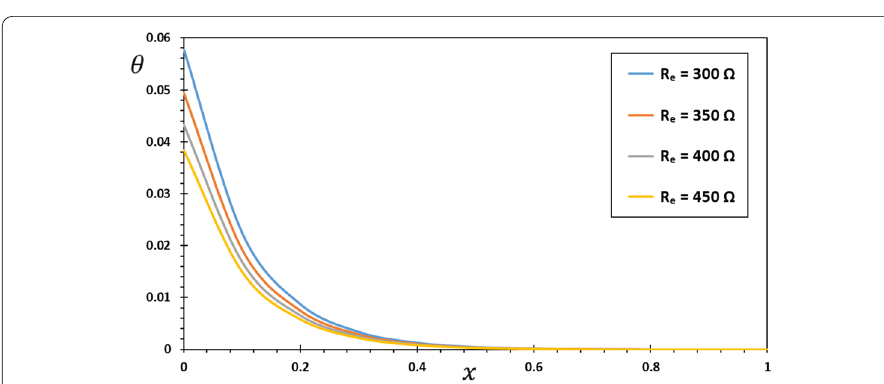
Figure 15 The effect of electric resistance Re on the variation of temperature θ